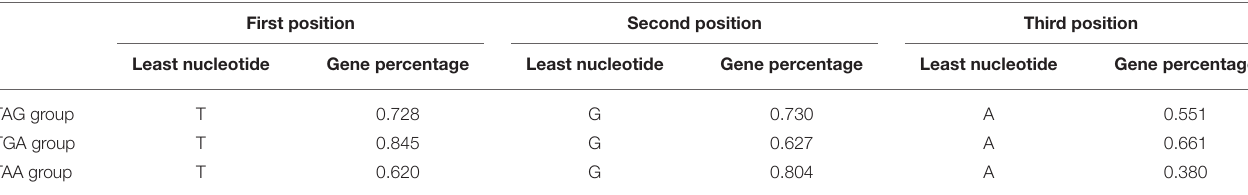
TABLE 2 | Percentage of genes with nucleotides with the least frequency at the first, second, and third positions in three groups of genes a . First position Second position Third position Least nucleotide Gene percentage Least nucleotide Gene percentage Least nucleotide Gene percentage TAG group T